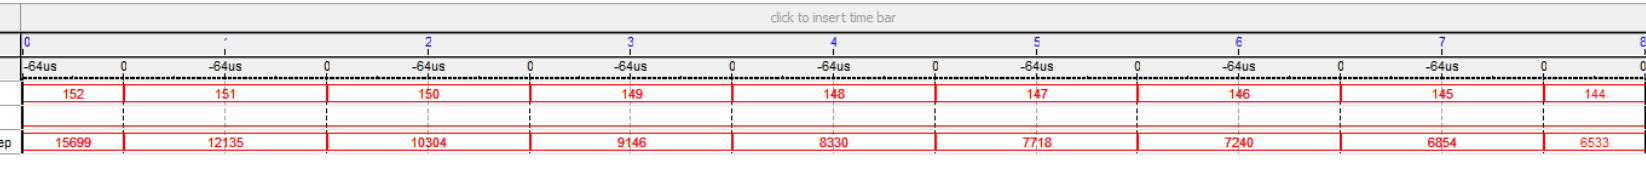
Figure 19. Simulation of a SPSS ±20° and 1 Hz stimulus for a 50 cm patient-stimulus distance.